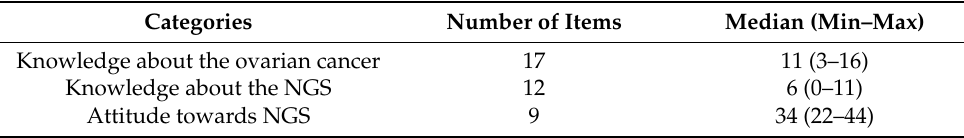
Table 3. Knowledge about the ovarian cancer and NGS and attitude towards